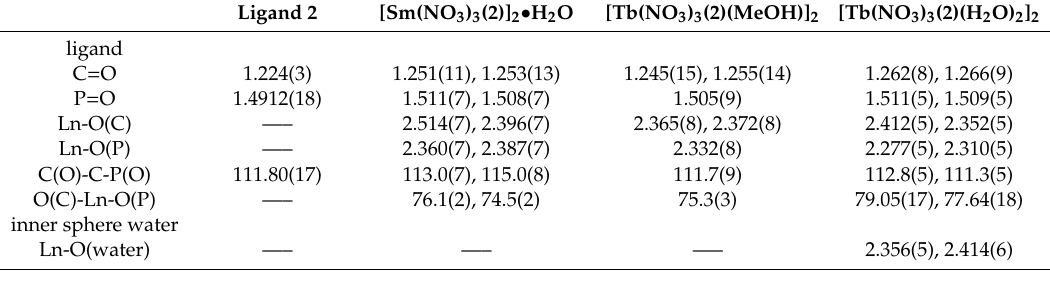
Table 4. Selected bond distances (Å) and angles ( ◦ ) for ligand 2 and its Sm(NO 3 ) 3 and Tb(NO 3 ) 3 complexes. For the Tb(NO 3 ) 3 complex, only the atoms that were not disordered are included here.